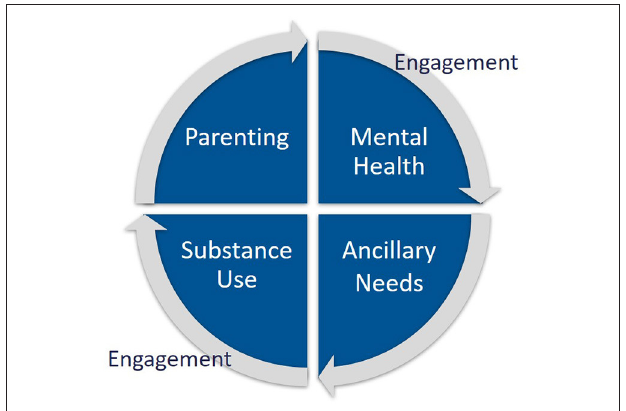
FIGURE 2 | Core treatment components of the FAIR program, supported by ongoing active engagement.